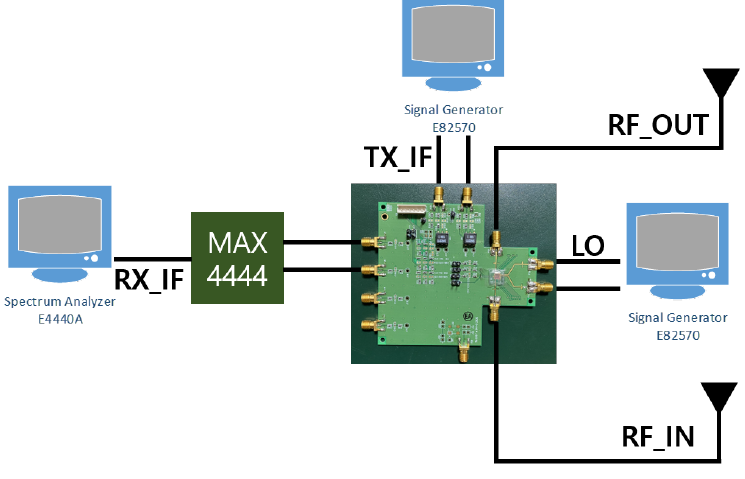
Figure 31. PCB and radar test